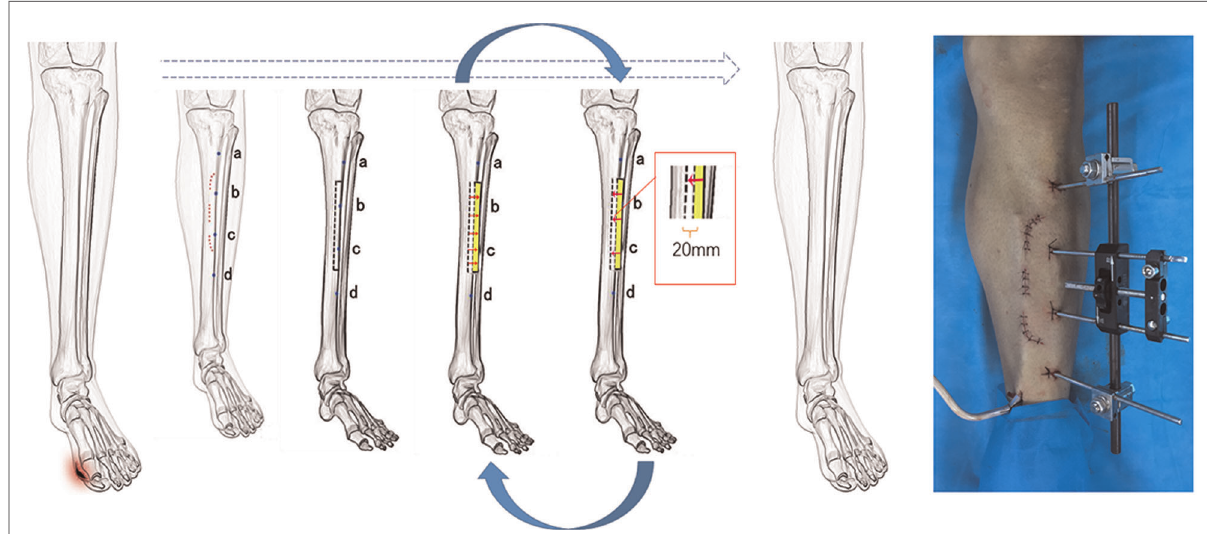
FIGURE 2 Schematic diagram of the surgical operation process, showing the surgical operation design and the installation of external fi xation systems. The red dotted line indicates the operative incision. The black dotted line indicates the range of the bone fl ap. The blue dots (a, b, c, and d) indicate the position of the four metal pins. One treatment cycle is approximately 20